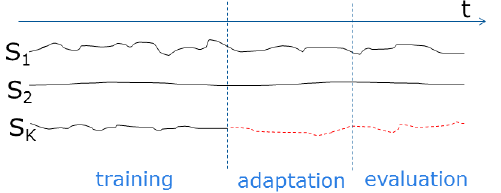
Figure 6. Illustration of training, adaptation and evaluation periods in the BRASS project evaluation. We use data from K sensors ( S 1 , S 2 , · · · , S K ). The training period generates data without sensor change for 2 months. The adaptation period generates data for 1 month, in which S K is replaced by a different sensor at the beginning. The evaluation period uses data from the next 1 month.